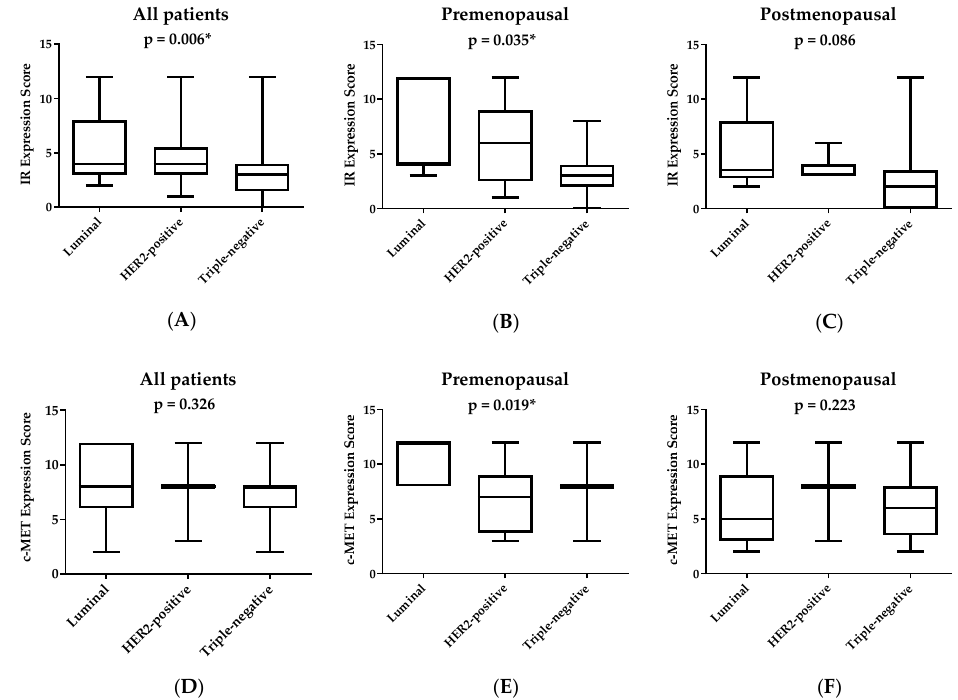
Figure 2. Expression of IR and c-MET among breast cancer patients according to molecular subtype and menopausal status. IR, insulin receptor. Boxplots represent median IR scores ( A – C ) and c-MET scores ( D – F ). The boxes represent the 25th and 75th percentiles, whereas the bars represent minimum and maximum values. * p < 0.05 between molecular subtypes, according to Kruskal–Wallis analysis of variance.